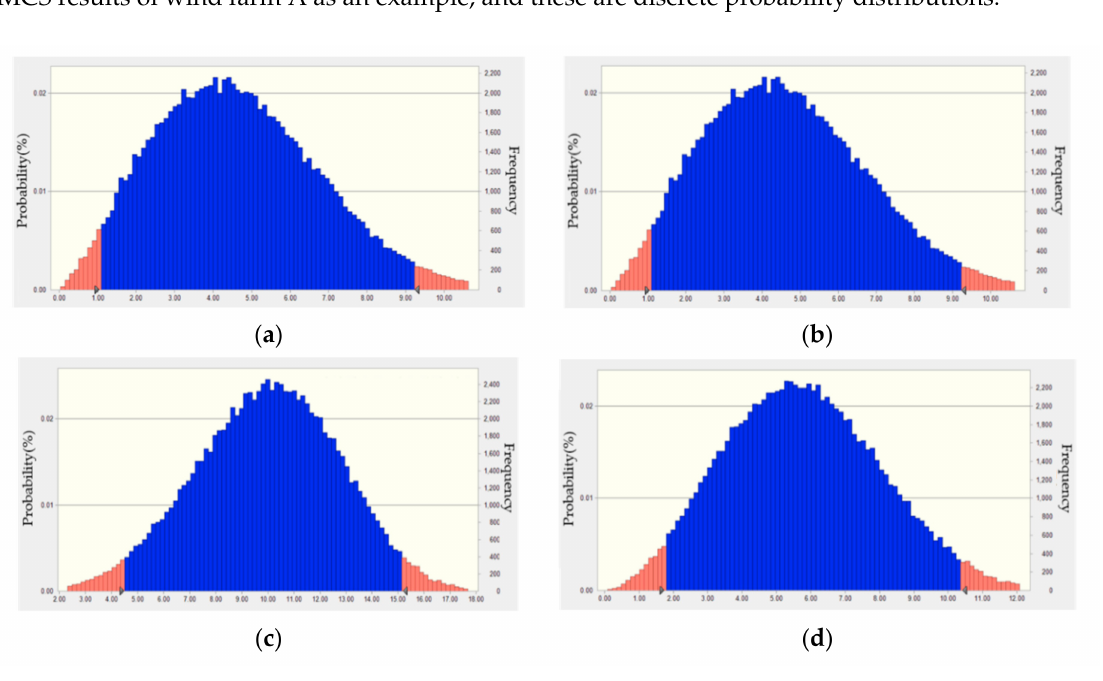
Figure 5. Seasonal Monte-Carlo simulation results allocated with a confidence interval of wind power outputs in wind farm A: ( a ) The MCS results of spring; ( b ) the MCS results of summer; ( c ) the MCS results of fall; ( d ) the MCS results of